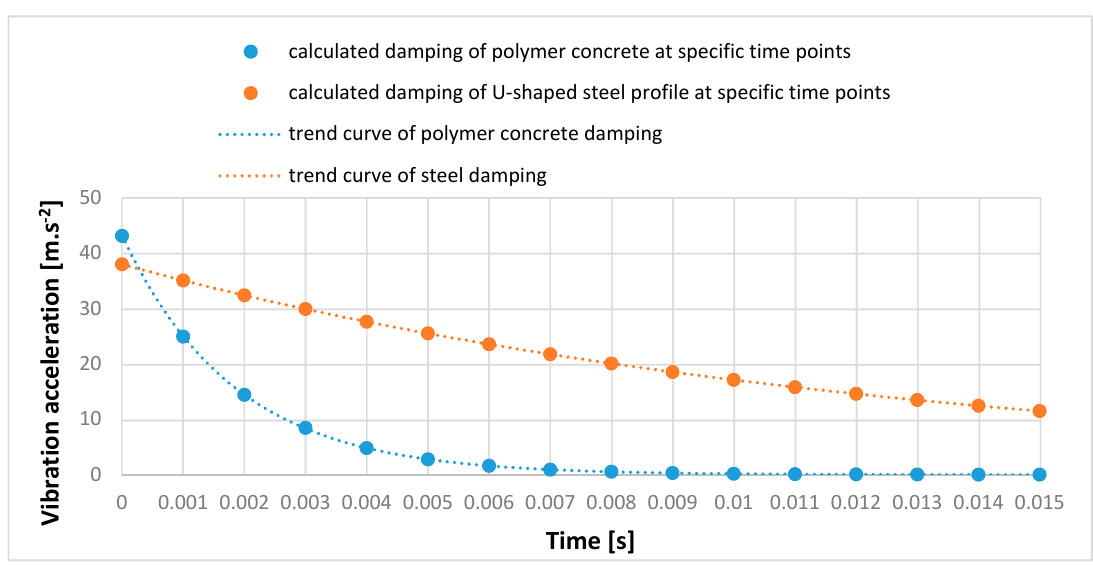
Figure 14. The comparison of calculated damping of polymer concrete and U-shaped steel profile.